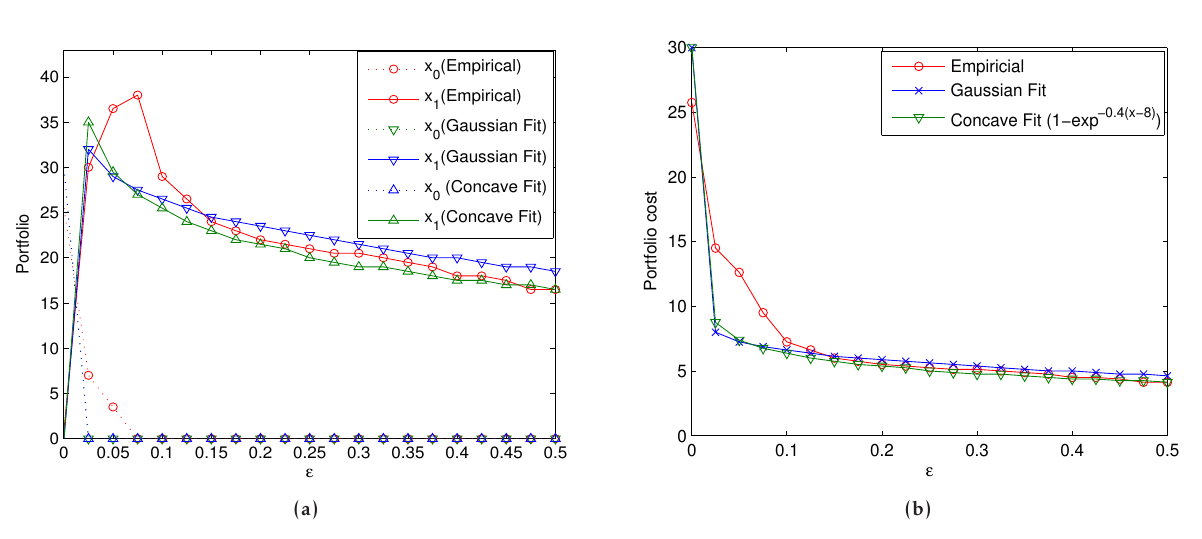
Figure 4. SPO solution for empirical and fitted distributions under DSP constraint. a) Number of primary and secondary contract units in the optimal portfolio, b) Portfolio cost.